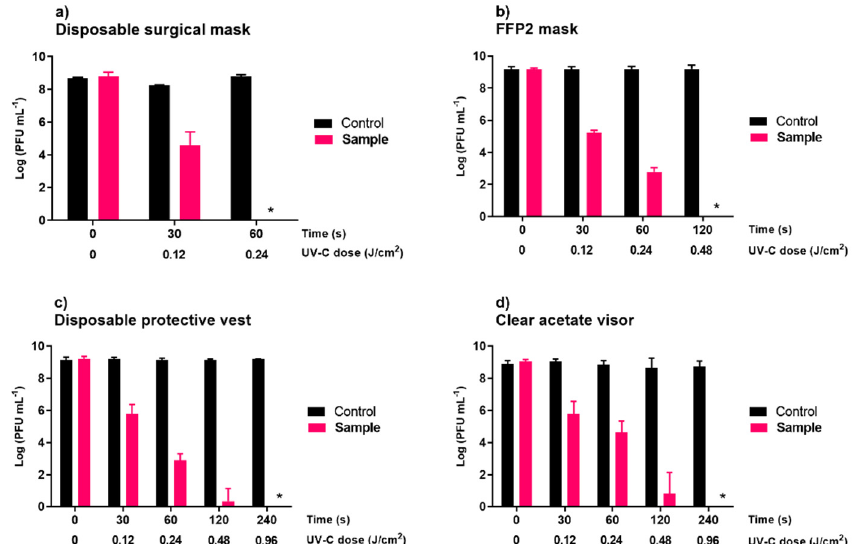
Figure 4. Inactivation of phage φ 6 by the UV-C sterilizing chamber (8)5.5W on disposable surgical ( a ) and FFP2 ( b ) masks, disposable protective vest ( c ), and clear acetate visor ( d ). Limit of detection was about 2.3 log PFU/mL Values represent the mean of the three experiments and error bars represent the standard deviation. * below the methods’ detection limit.